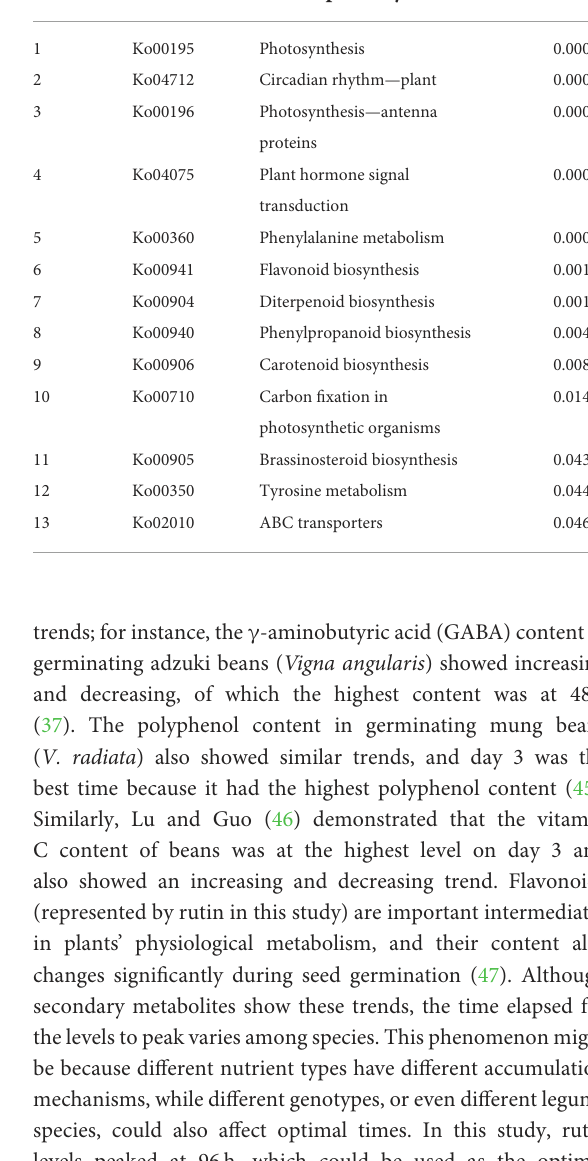
TABLE 6 The enriched pathways of differentially expressed genes (DEGs) compared 3d + S-0h vs. 3d + S-24h in KEGG analysis.